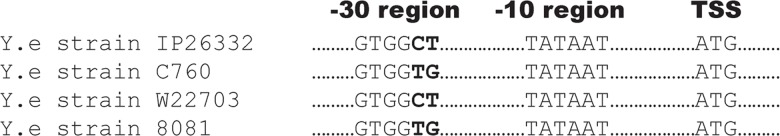
Multiple sequence alignment of the promoter region of
blaA of
Y.enterocolitica biovar IA, 1B, 2 and
4 strains.The transcription start site (TSS), -10 and -30 regions are shown. The -10
region was conserved but variations were observed in the -30 region.